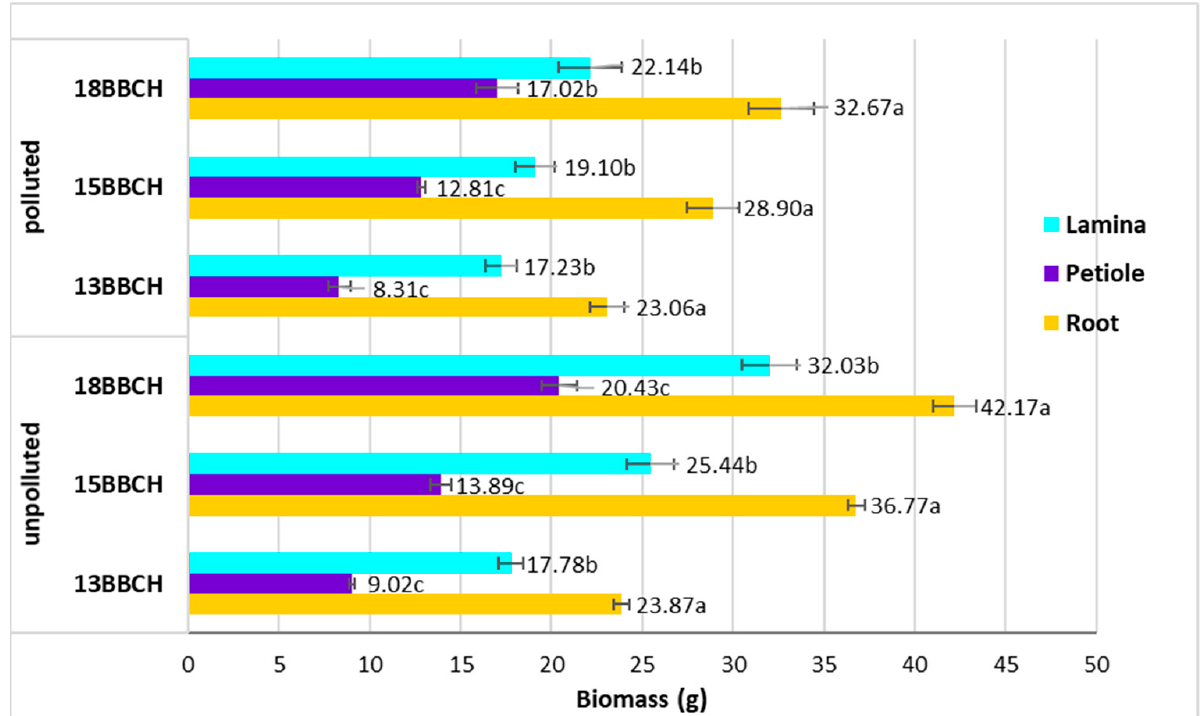
Figure 8. Fresh biomass of S. perfoliatum organs for different development stages when grown in heavy metal Ps and Us. Error bars represent SE. Different letters (a–c) indicate significant differences ( p < 0.05) between plant